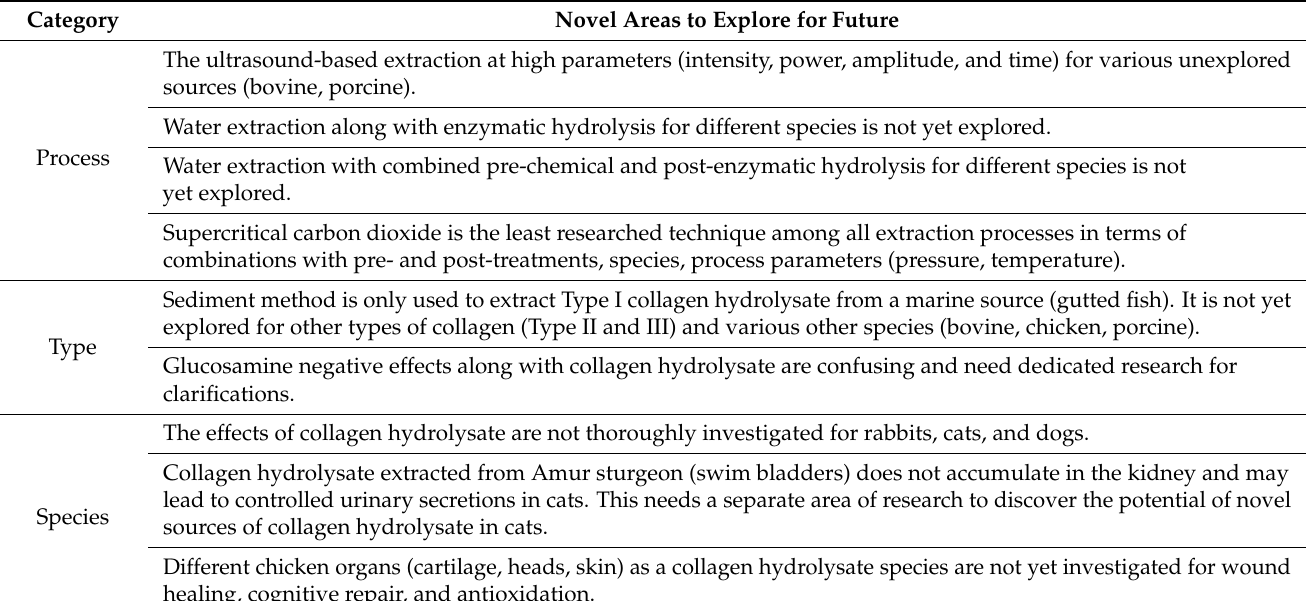
Table 9. Novelties concluded in this